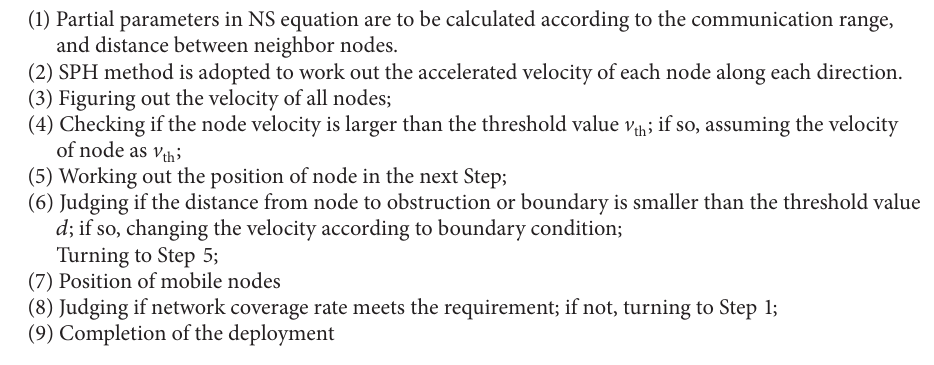
Algorithm 1: Node deployment algorithm based on flow field model.